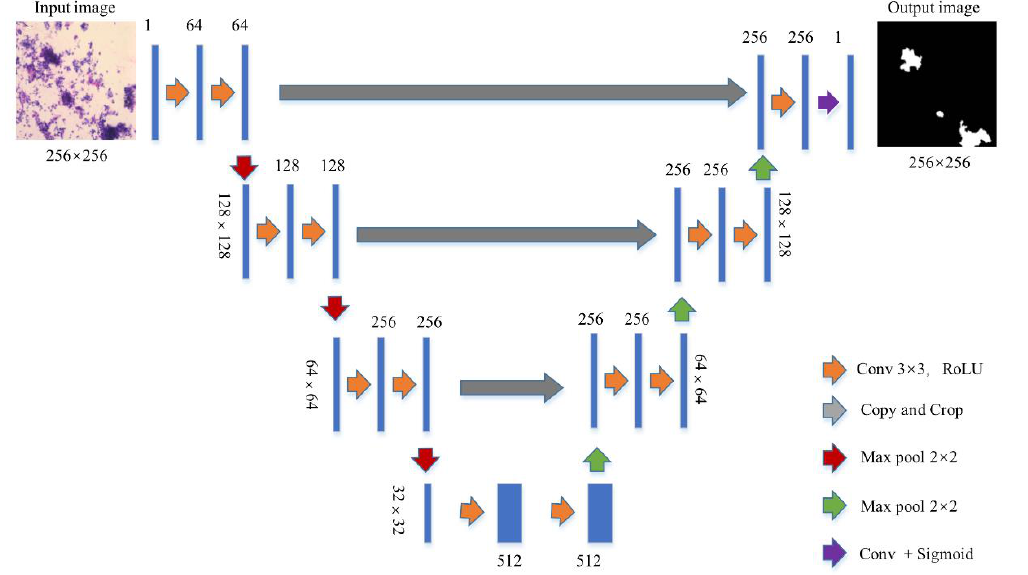
Figure 2. Segmentation network. The blue box represents the feature map. The yellow arrow represents 3 × 3 convolution and striding of 1 used for feature extraction; we set the padding as 1 to ensure that the size of the convolutional image at the same steps was stable. The gray arrow indicates skip-connection, which is used for feature fusion, and pure up-sampling will cause the loss of information. The red arrow indicates the 2 × 2 maximum pooling, which is used to reduce the dimensionality. The green arrow indicates up-sampling, which is used to restore the dimension. The cyan arrow indicates the convolution plus activation function, which is used to output the result. 2 | A ∩ B | Dice = A +